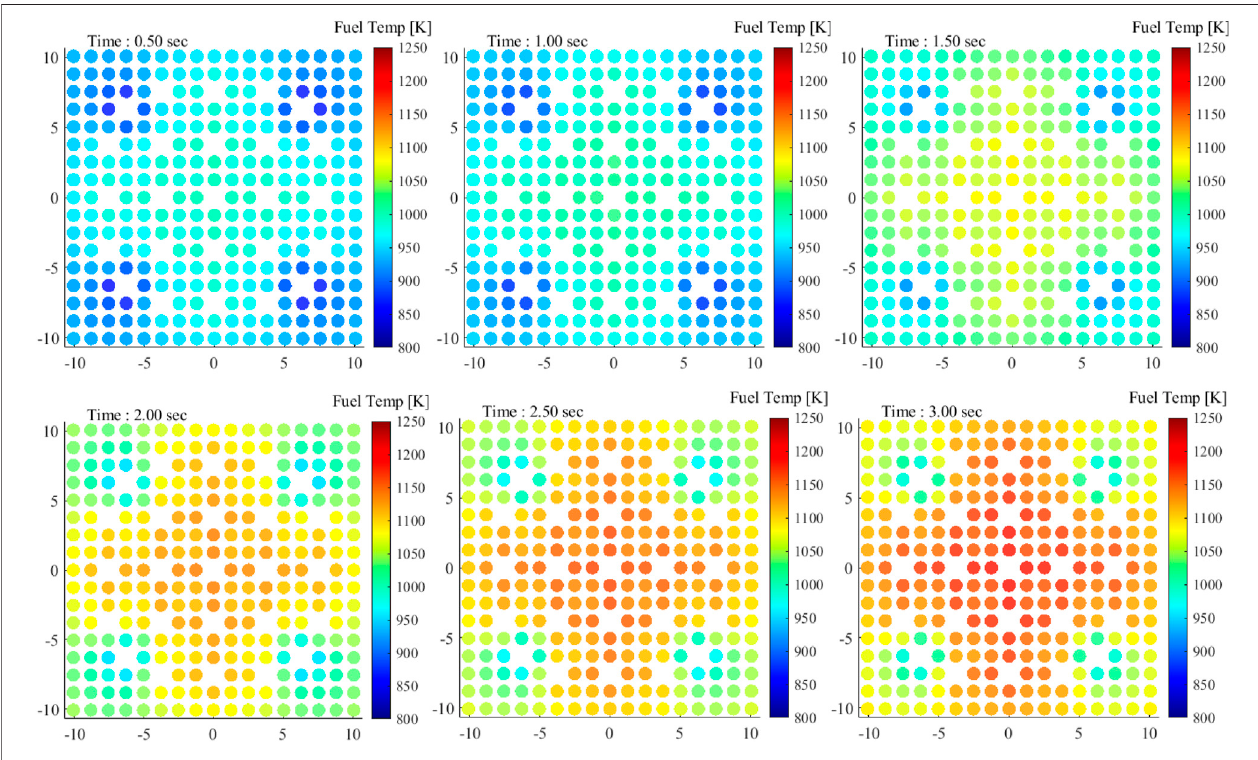
FIGURE 8 | Time-dependent fuel temperature distribution from 0.5 to 3